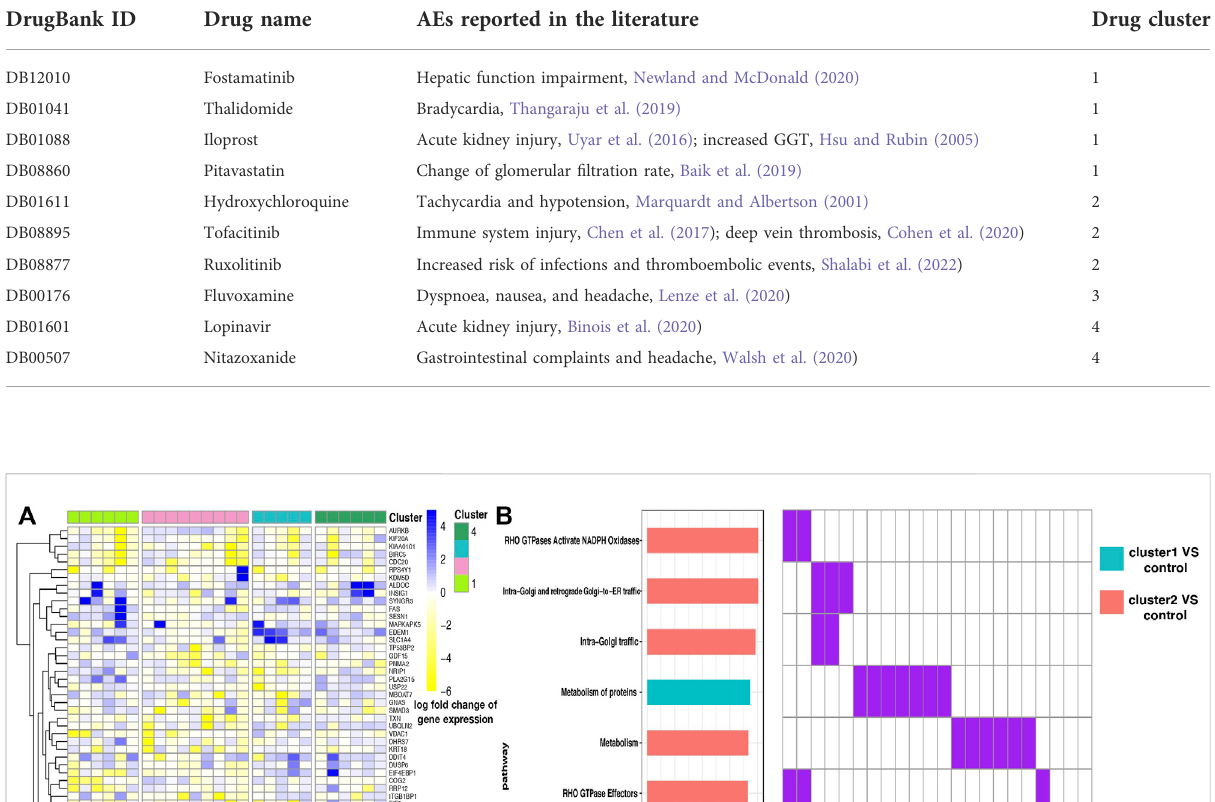
drug cluster 1 – control pair and 2 – control pair were collected for further validation. A biological function enrichment analysis was implemented to uncover the possible relationships between enriched pathways and representative differential AEs in the pair of drug clusters (see Supplementary Material).